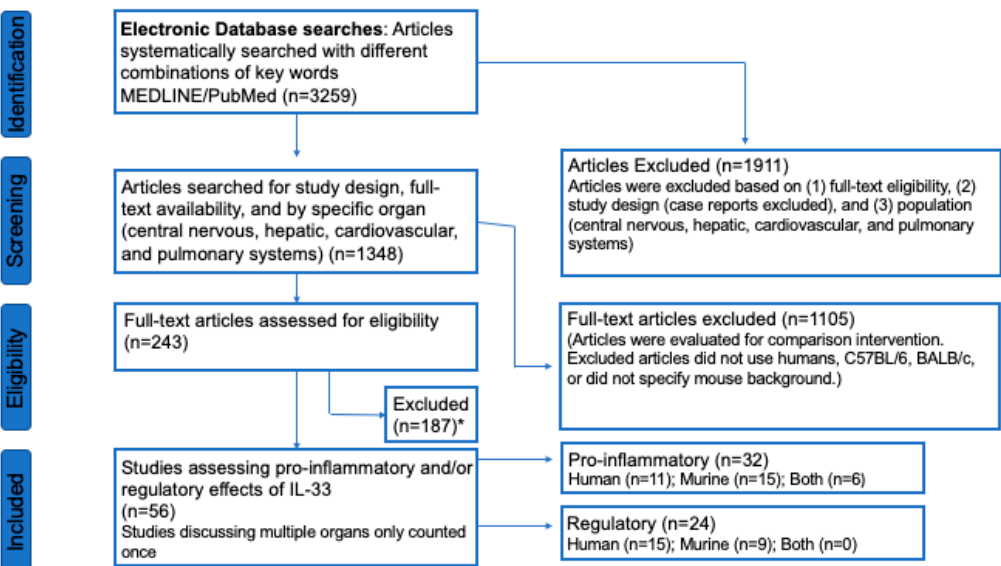
Figure 3. PRISMA Study Selection Flow Diagram. The PRISMA Flow Diagram demonstrates each phase of the search strategy in which articles were evaluated. During each phase, articles were excluded based on our defined criteria. The last phase of exclusion resulted in a final collection of articles, which were then divided into a pro-inflammatory or regulatory. These articles were then further broken down by population, including humans, mice, and both. * The majority of full-text articles were excluded because they were review articles published prior to December 31 2017, IL-33 was not a main focus of the article, or the article was not available in English.